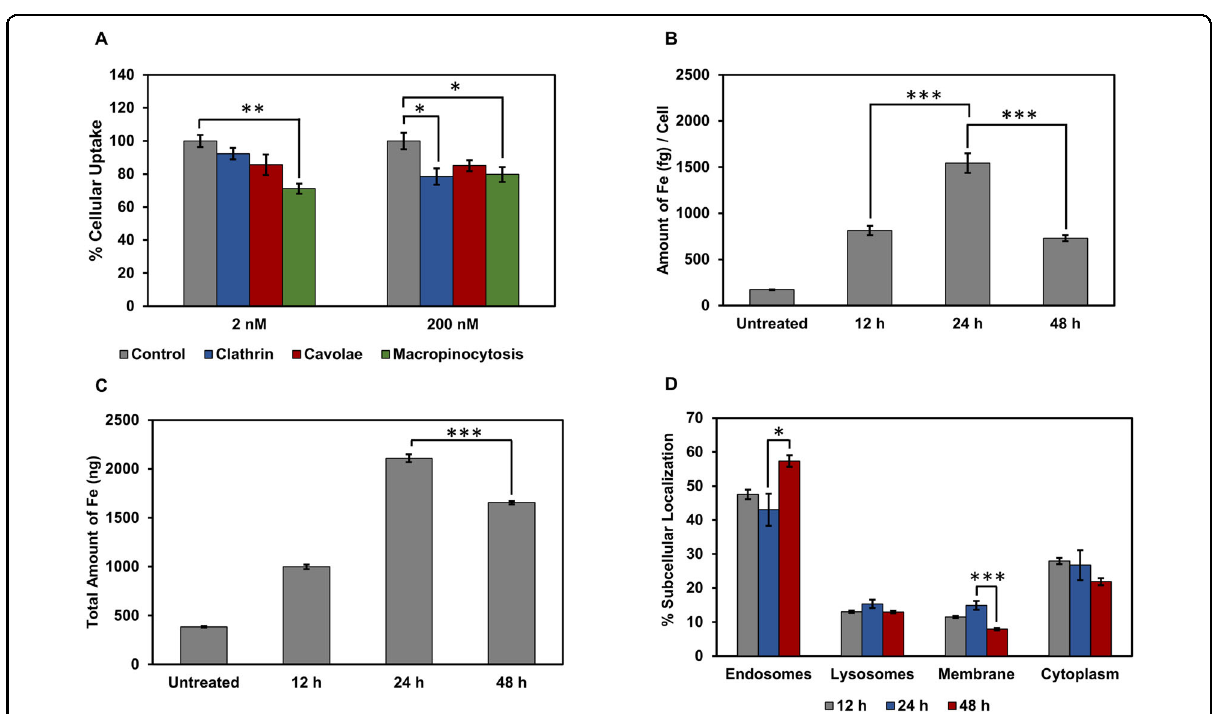
Fig. 2 Endocytosis pathway and localization. A Endocytosis pathway determined with cells incubated with 200 nM AfFtnAA for 2 h in the presence of inhibitors to test for clathrin-mediated endocytosis, caveolae-mediated endocytosis and macropinocytosis. B Amount of Fe accumulated per cell. C Total amount of Fe per well in cells incubated with 200 nM AfFtnAA for 12, 24 and 48 h. Untreated cells were not incubated with AfFtnAA ( n = 3). D Percent Fe distribution measured in the endosomes, lysosomes, membranes, and cytoplasm in cells incubated with AfFtnAA for 12, 24 and 48 h ( n = 2). The percent localization was calculated based on the total amount of Fe detected per cell (* p < 0.05, ** p < 0.01, *** p <